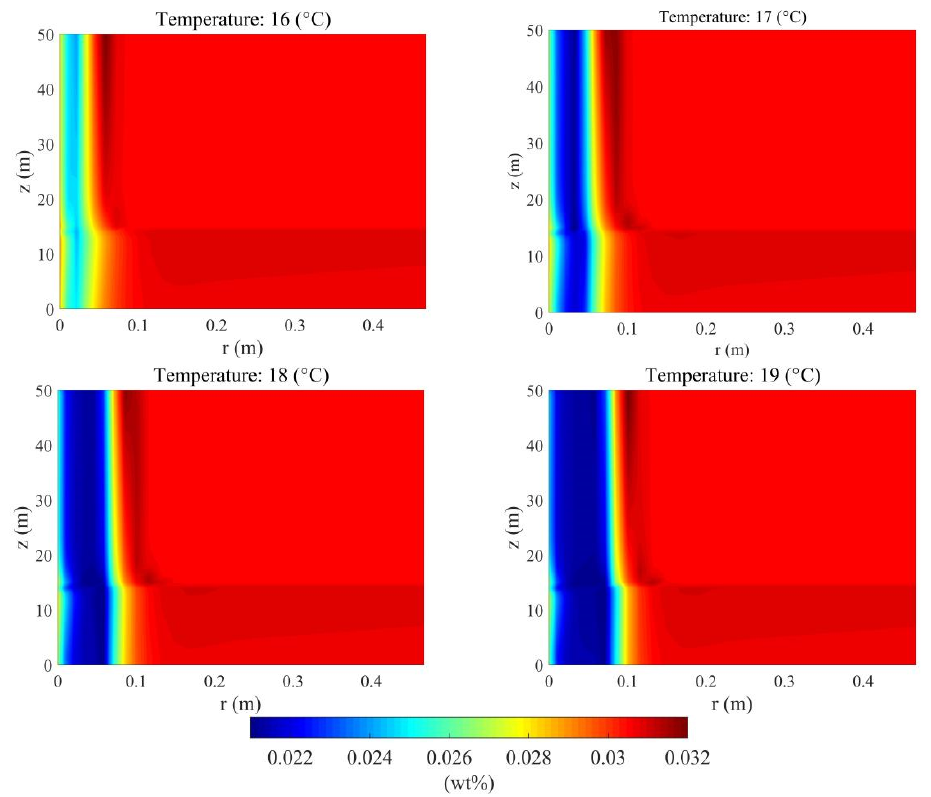
Figure 12. Comparison of two-dimensional salinity distribution of hydrate reservoirs for a fixed salinity of 3.05 wt% at the 24th hour of drilling fluid invasion under different drilling fluid